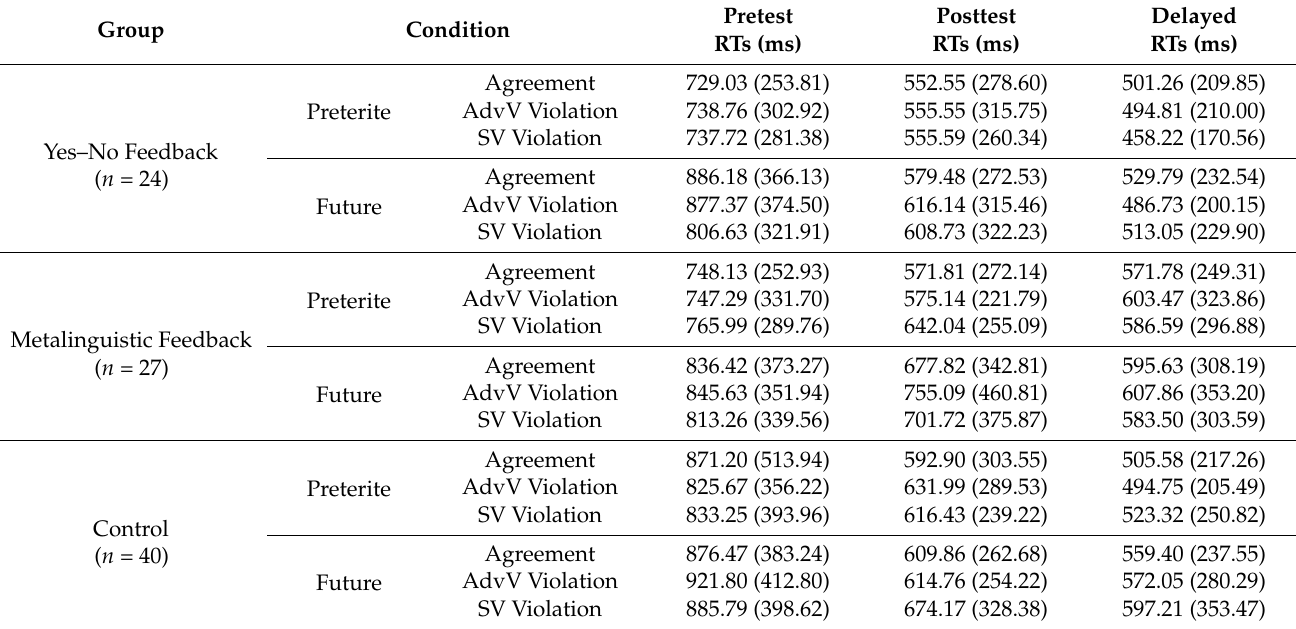
Table 8. Trimmed Mean Reading Times (RTs) (SDs) for Critical Region